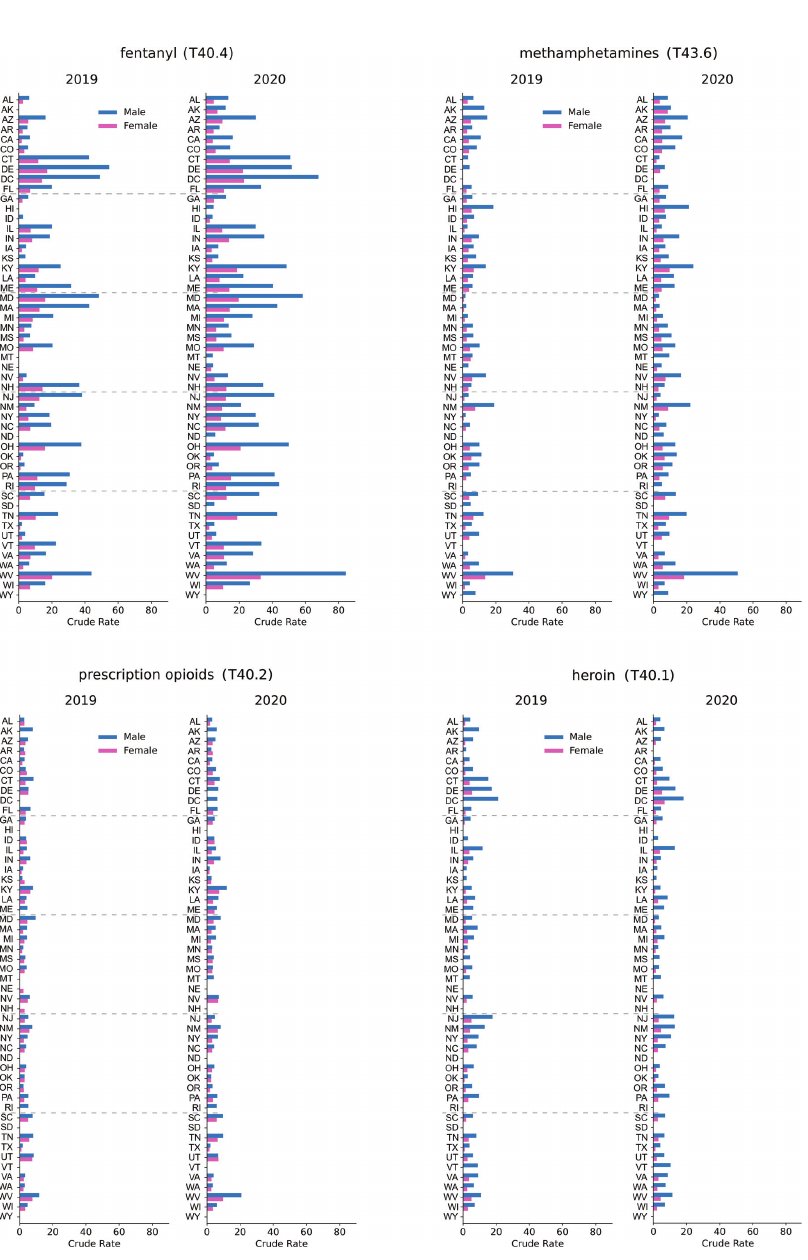
Fig 5. Gender-stratified, crude rates across the United States associated with fentanyl (T40.4), methamphetamines (T43.6), prescription opioids (T40.2), heroin (T40.1) for the years 2019 and 2020. Note the gender imbalances and increase in mortality for West Virginia from 2019 to 2020 for all drug categories except